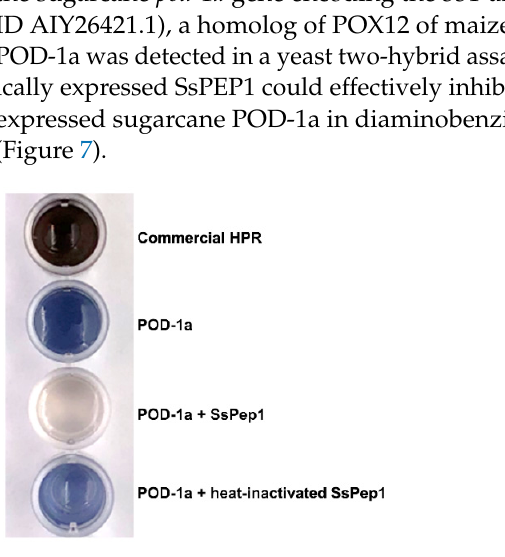
minobenzidine (DAB) and hydrogen peroxide (H 2 O 2 ). The addition of peroxidase into the sub-